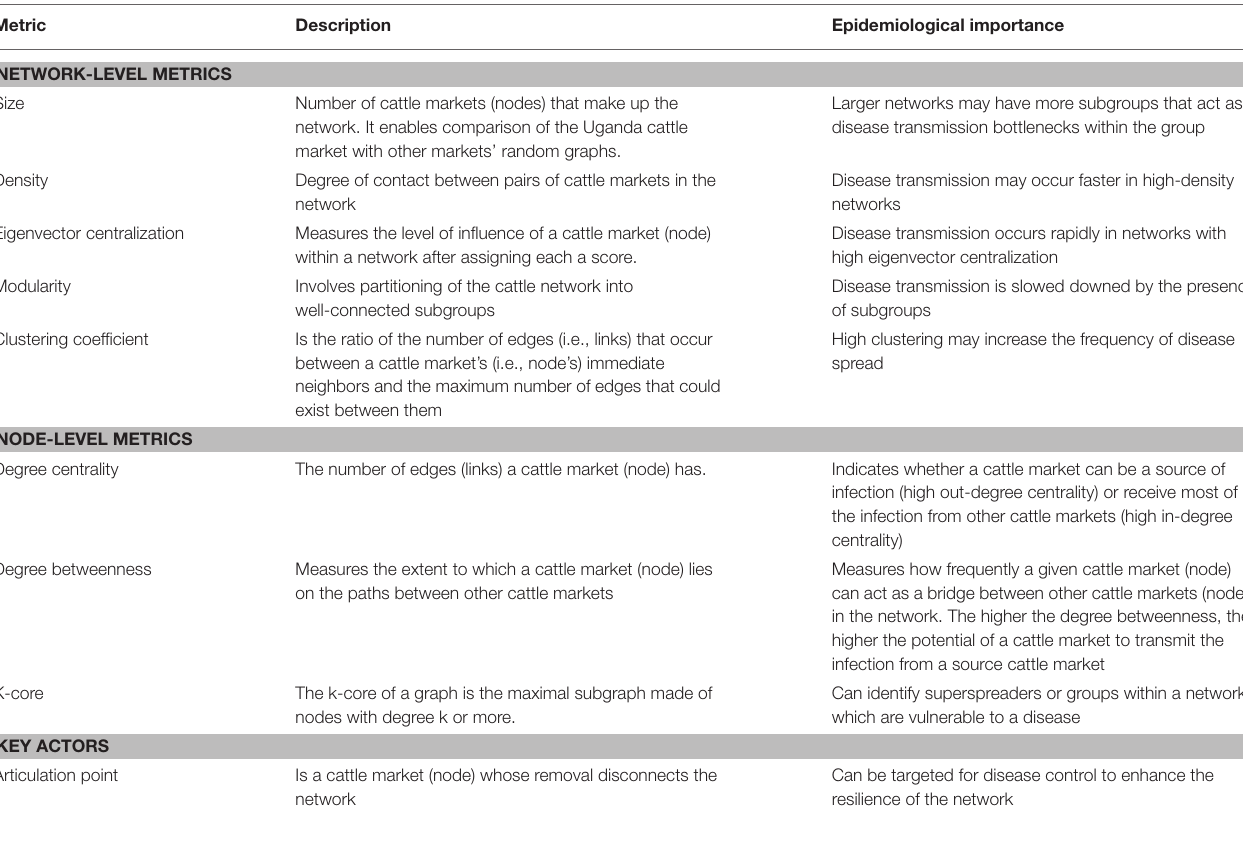
TABLE 1 | Description of network and node level